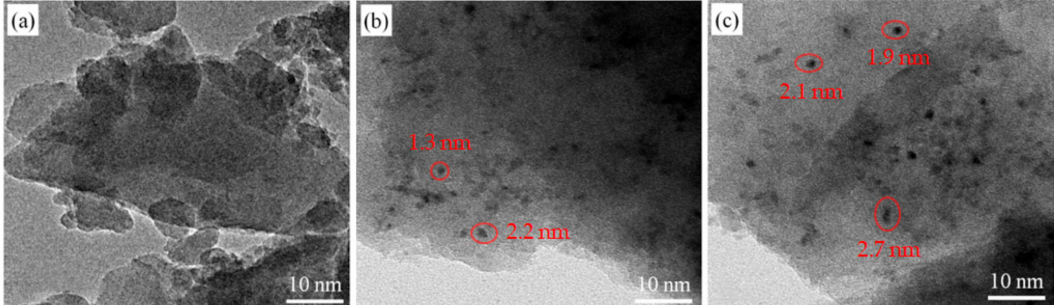
Figure 6. TEM images of unsupported Co/MSiO 2 materials with n Co = ( a ) 0, ( b ) 0.08, and ( c ) 0.15 calcined in N 2 atmosphere at 400 ◦